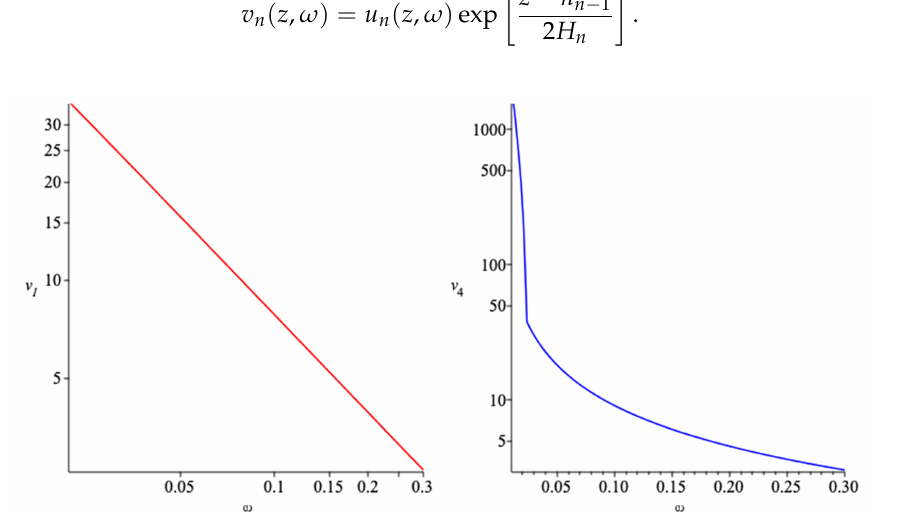
Figure 2. This figure is the log–log plot of velocity solution illustration. v 1 is depicted at a height of h 1 = 10,000 m, the boundary between the first and the second layer. v 4 is depicted at a height of h 3 = 90,000 m, the boundary between the third and the fourth layer, H 1 = 7390 m, the average scale height in the first layer, and H 4 = 24,190 m, the average scale height in the fourth layer. For the parameter λ , we take 1/300 1/s